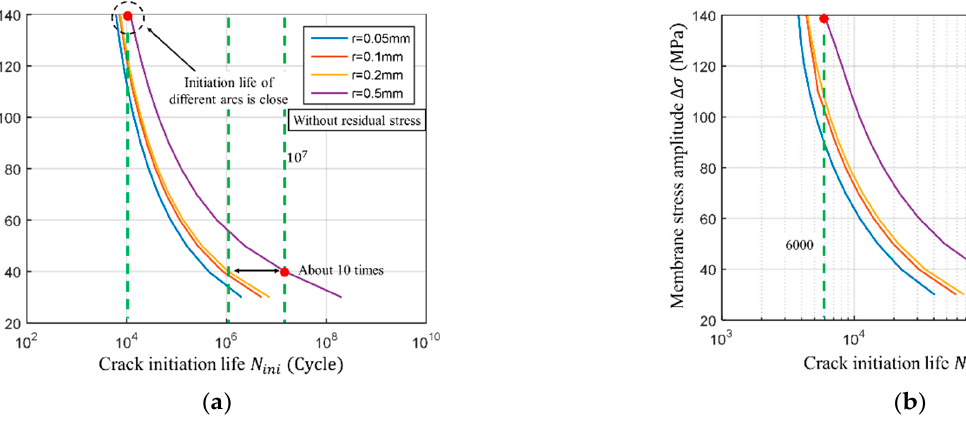
Figure 18. Results of S − N curve at crack initiation stage. ( a ) S − N curve of crack initiation with different notch radius without residual stress; ( b ) S − N curve of crack initiation with different notch radius with residual